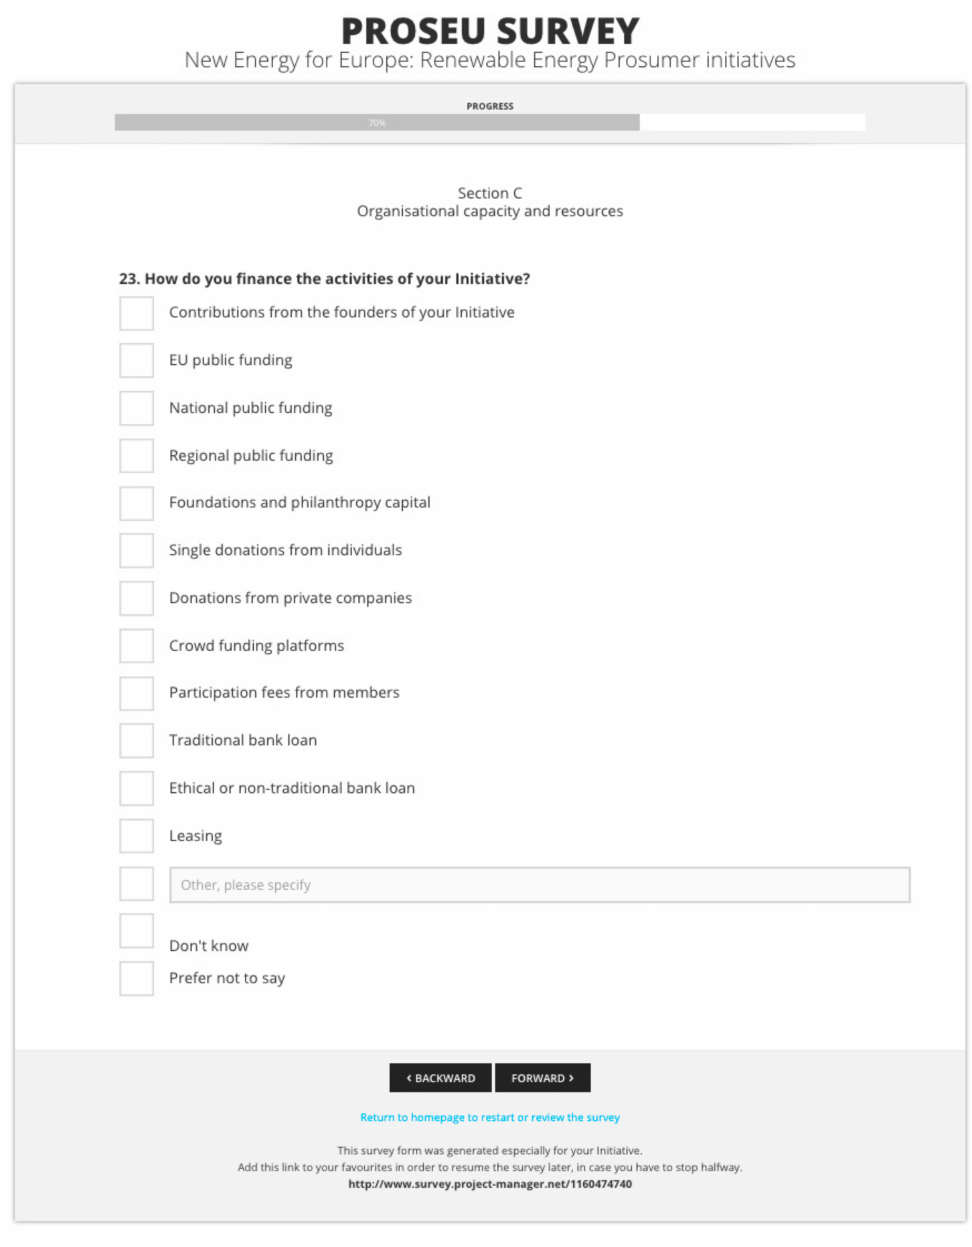
Figure A4. Question 23 of the survey